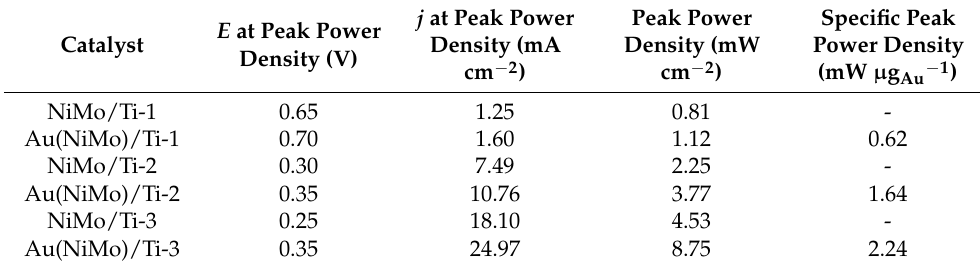
Table 3. Electrochemical parameters of C 6 H 12 O 6 -H 2 O 2 using different NiMo/Ti and Au(NiMo)/Ti anode